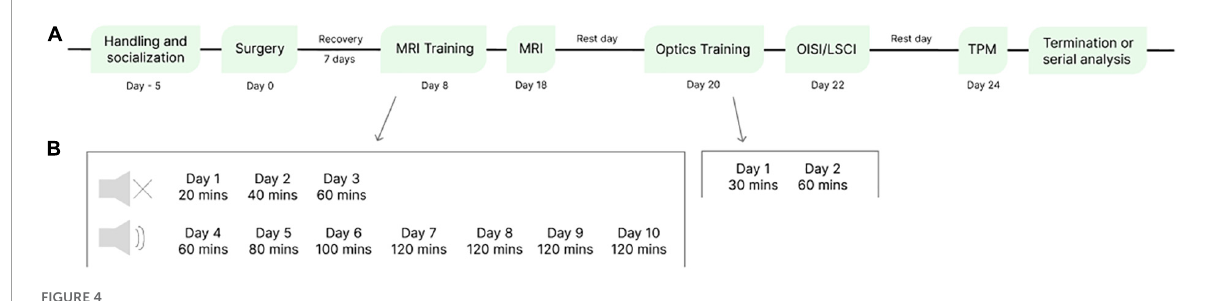
FIGURE4 Experimental timeline. (A) Timeline from handling and socialization of mice to experiment termination. Surgery per animal was approximately 1 h and 30 min, training consisted of 10 days of restraint acclimation, followed by image acquisition with MRI, 2 days of optics training, OISI/LSCI, and TPM. Following image acquisition, the experiment can be terminated or continued as a longitudinal study. (B) Training protocols for MRI and optical imaging. MRI training days 1–3 were conducted without MRI